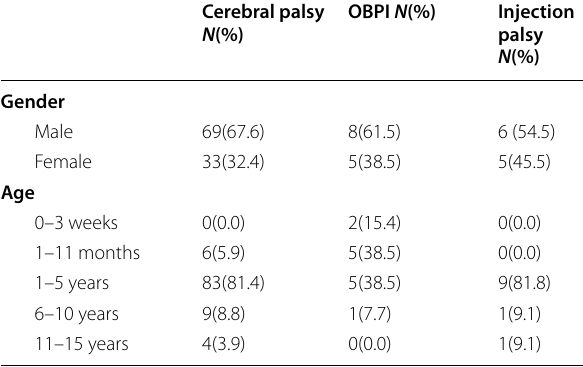
Table 3 Pattern of conditions managed by physiotherapists at